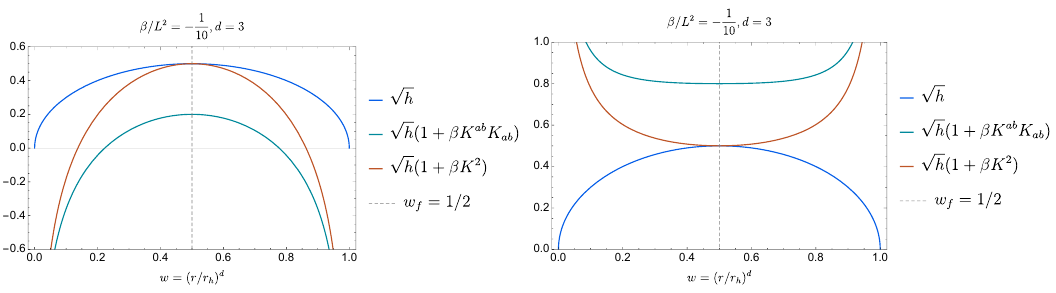
) for different C gen h = 1 , d = 3 for this plot. L 2 50